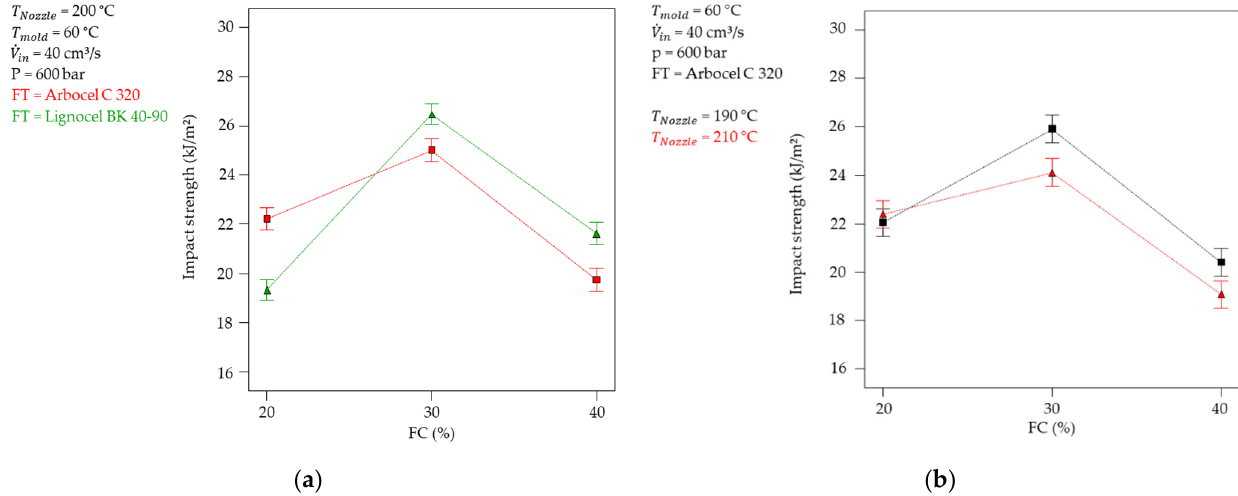
( b ) Figure 5. ( a ) Young’s modulus of wood ‐ filled TPU as a function of fiber content and fiber type. ( b ) Young´s modulus of wood ‐ filled TPU in dependence of temperature control.